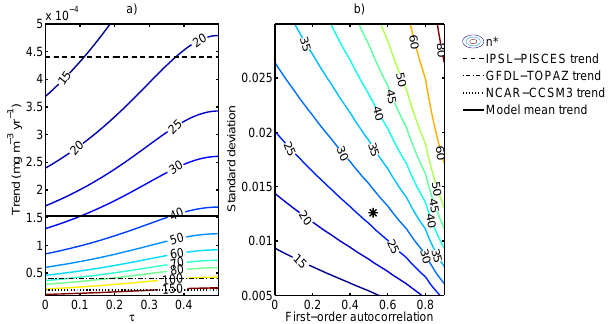
Fig. 4. (a) Number of years of observations ( n ∗ ) necessary to de- tect a statistically significant trend in satellite monthly ocean chloro- phyll according to the magnitude of the trend and of the fraction of data before the discontinuity ( τ ). The standard deviation and auto- correlation used in the calculations were estimated from global Sea- WiFS data from 1998–2007. The range for the trend magnitude was obtained from three biogeochemical models, and these magnitudes (in absolute value) are shown on the figure as well as the model mean trend (Table 2). We present the fraction of data before the dis- continuity between 0 and 0.5 only since the results are symmetric. For example, the number of years necessary to detect a trend of the same magnitude will be the same if the discontinuity occurs after 25% or 75% of the data were collected. (b) Number of years of continuous observations necessary to detect a trend (with the mag- nitude of the multi-model mean trend) in satellite ocean chlorophyll according to the autocorrelation and standard deviation in the data. The star in the figure shows the values observed in global SeaWiFS data from